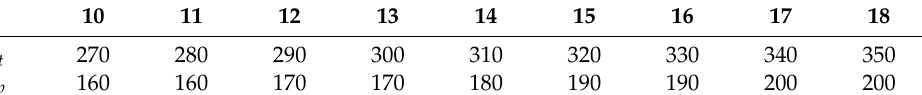
Figure 9. The relationship between the maximum value of balance driving force and the size.